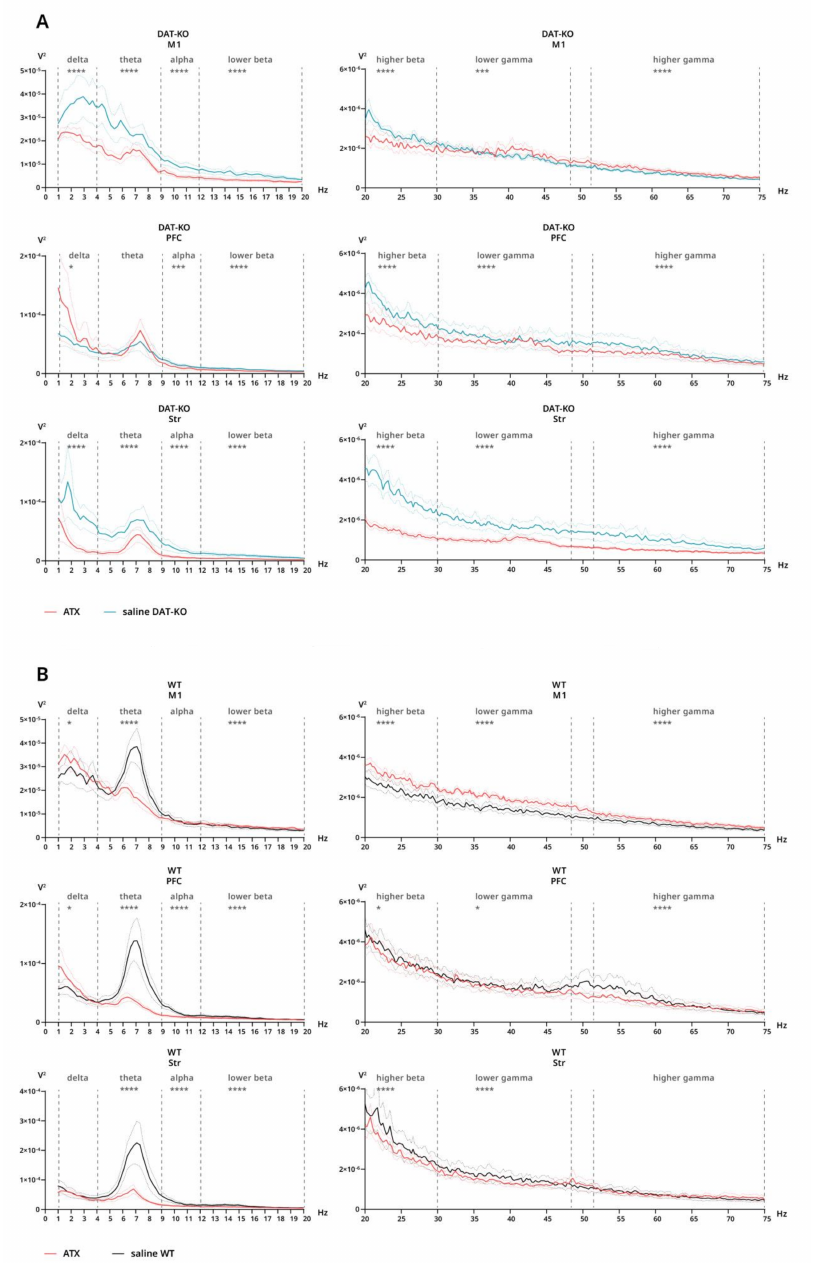
Figure 6. Power spectra of brain activity of DAT-KO and WT rats after saline and atomoxetine injections recorded from motor cortex (M1), prefrontal cortex (PFC) and striatum (Str). 20–75 Hz range presented separately due to scale difference. ( A ) Power after saline (teal) and ATX (red) in DAT-KO. ( B ) Power after saline (black) and ATX (red) in WT. Data are presented as mean (solid line) ± SEM (dotted line). Dashed lines represent electroencephalographic rhythms: delta (0.9–3 Hz), theta (4–8 Hz), alpha (9–11 Hz), lower beta (12–19 Hz), higher beta (20–29 Hz), lower gamma (30–48), higher gamma (52–74 Hz). * p < 0.05; *** p < 0.001; **** p < 0.0001; two-way